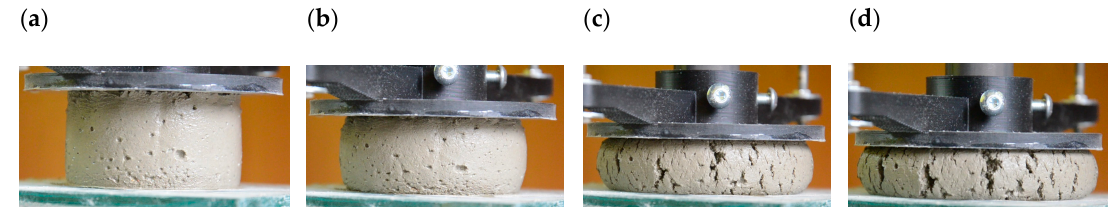
Figure 12. Analysis of specimen failure during the squeezing test—example 2. ( a )